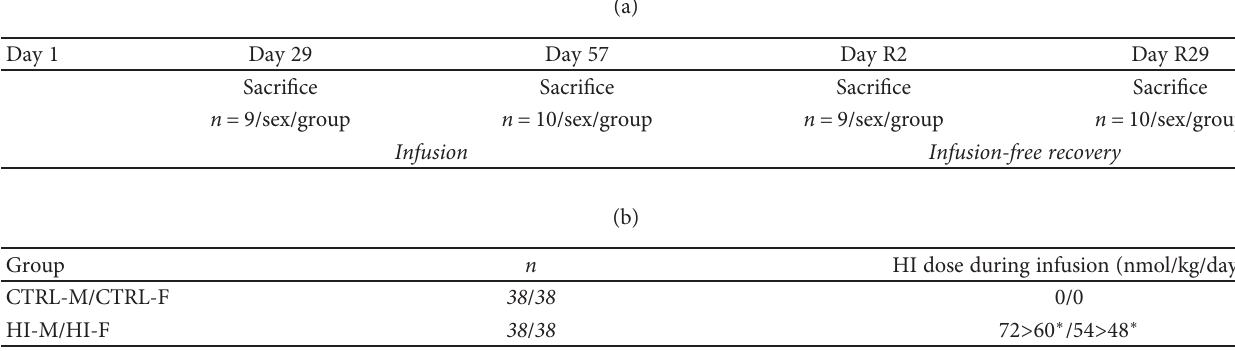
Table 1: Overview of study design (a) and doses